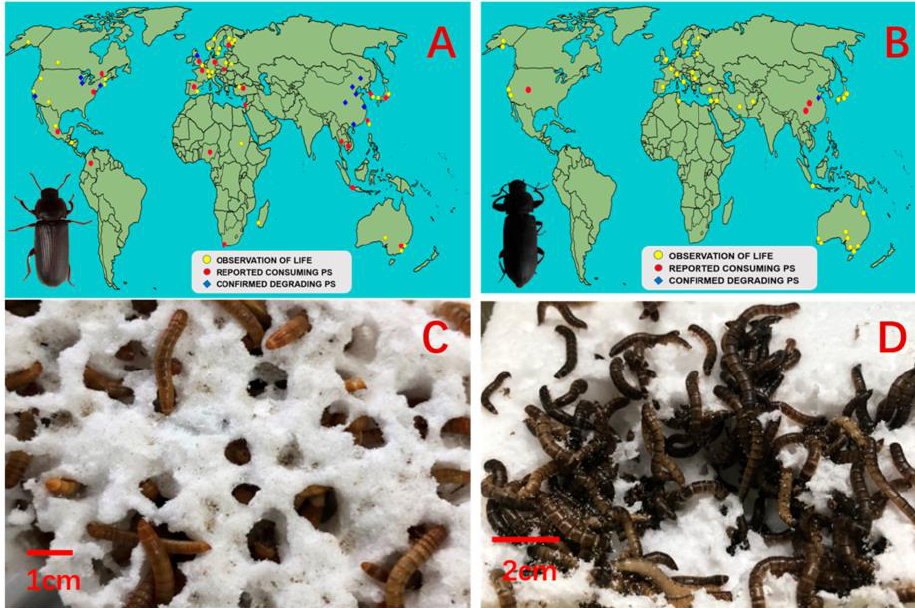
Figure 10. Tenebrio molitor and Tenebrio obscurus around the world and PS foam-eating behaviors. ( A ) Discovered life and original sources of T. molitor . ( B ) Discovered life and original sources of T. obscurus . ( C ) PS foam-eating T. molitor larvae and ( D ) T. obscurus larvae from Shandong Province, China, reprinted with permission from [44].